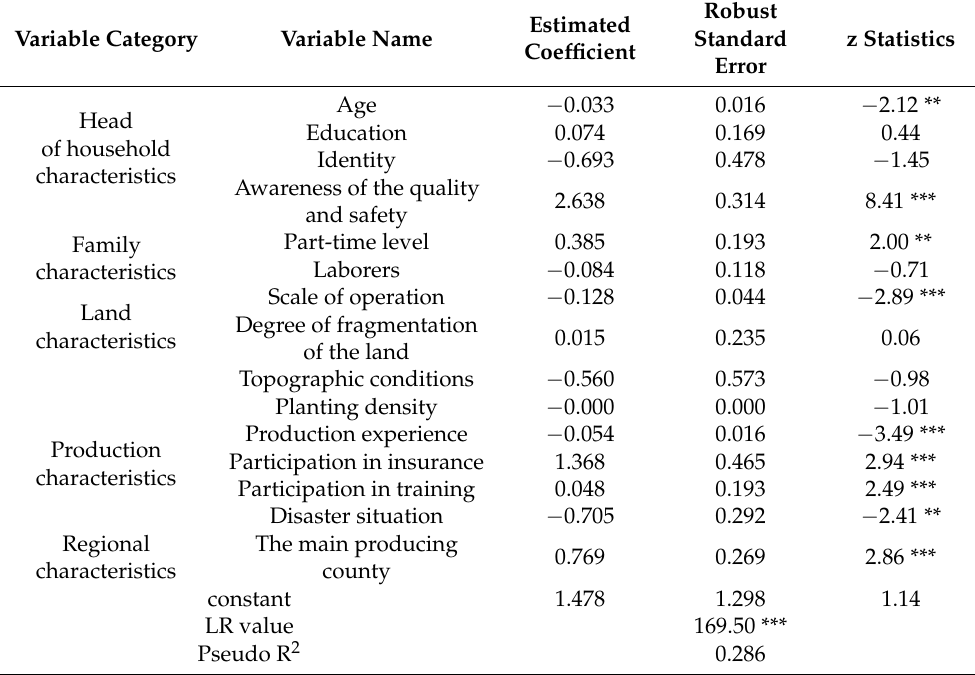
Table 4. Estimation results of the Logit model in which farmers use organic fertilizers instead of chemical